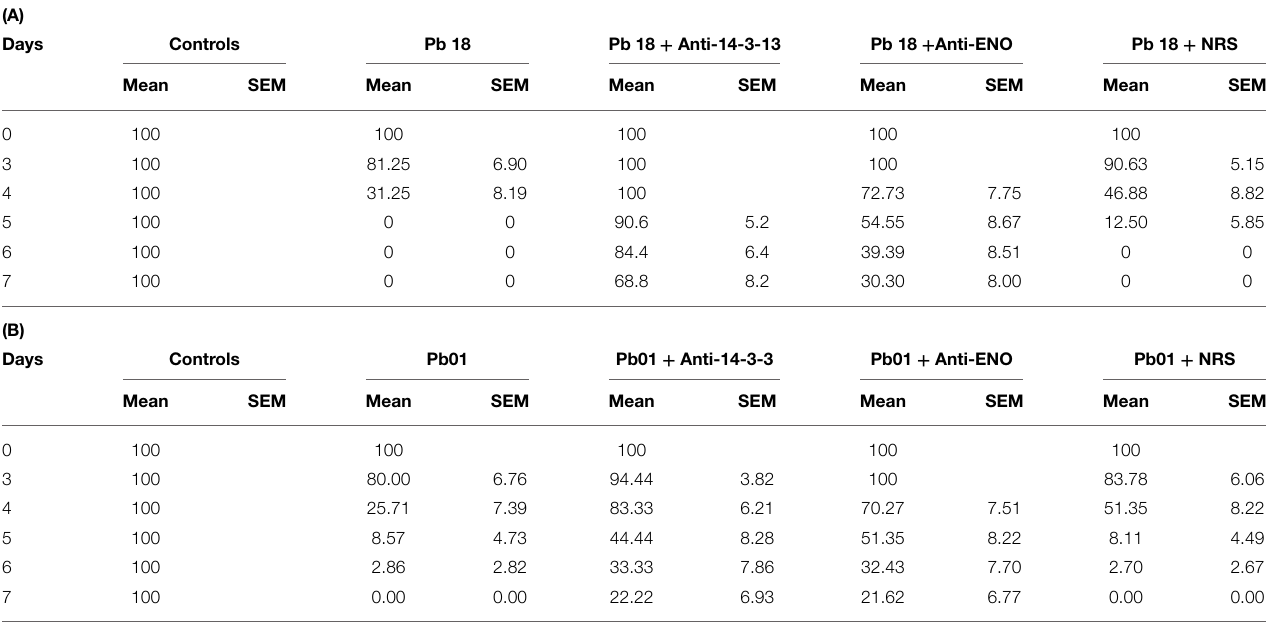
TABLE 2 | Standard deviations of the Galleria mellonella survival